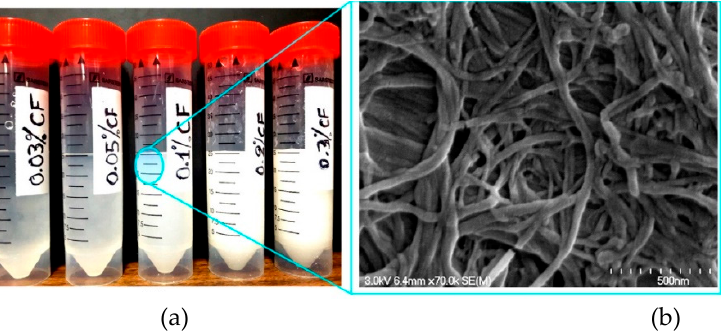
Figure 5. Cellulose filaments (CF): ( a ) CF-water suspensions for the different dosages tested in this study; ( b ) Scanning electron microscope (SEM) image of a suspension with 0.10% CF. Reproduced from Hisseine et al. [79] with permission from Elsevier.